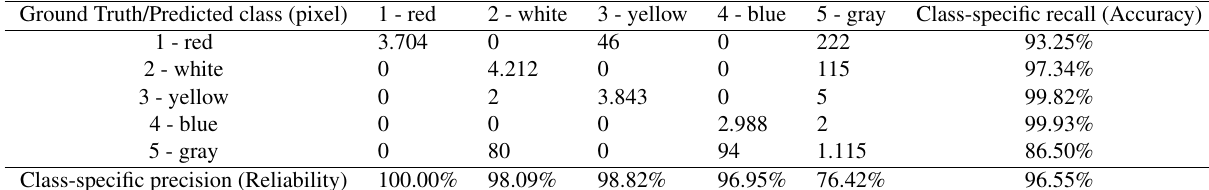
Table 1. Per pixel classification confusion matrix based on the orto rectified image of 2006 acquisition.